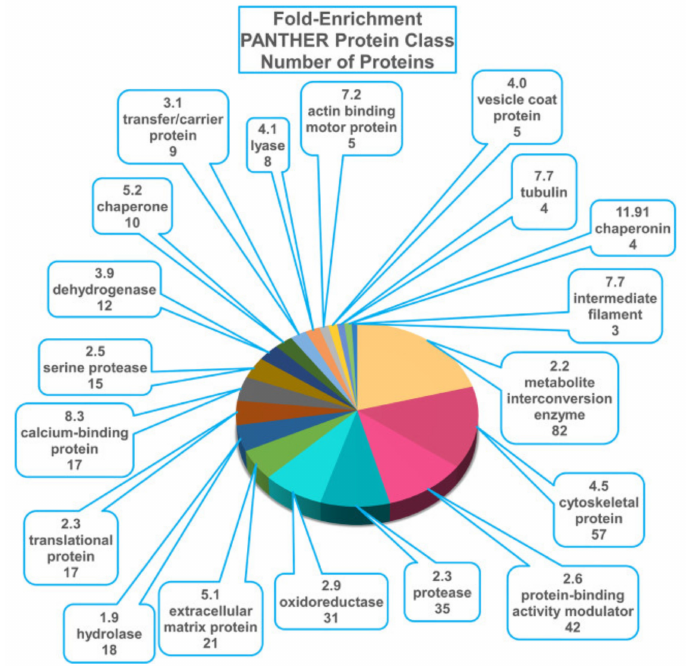
Figure 5. Composition of guinea pig perilymph proteome, by functional categories. The 620 gene names were searched against the mouse gene list in PANTHER (http://www/pantherdb.org (ac- cessed on 1 September 2020)) to determine the distribution of proteins across functional classes. The fold-enrichment, PANTHER protein class, and the number of proteins within each class are presented. (Reprinted with permission from Ref. [39], 2021, Jeffrey W. Kysar, PhD and Anil K. Lalwani,